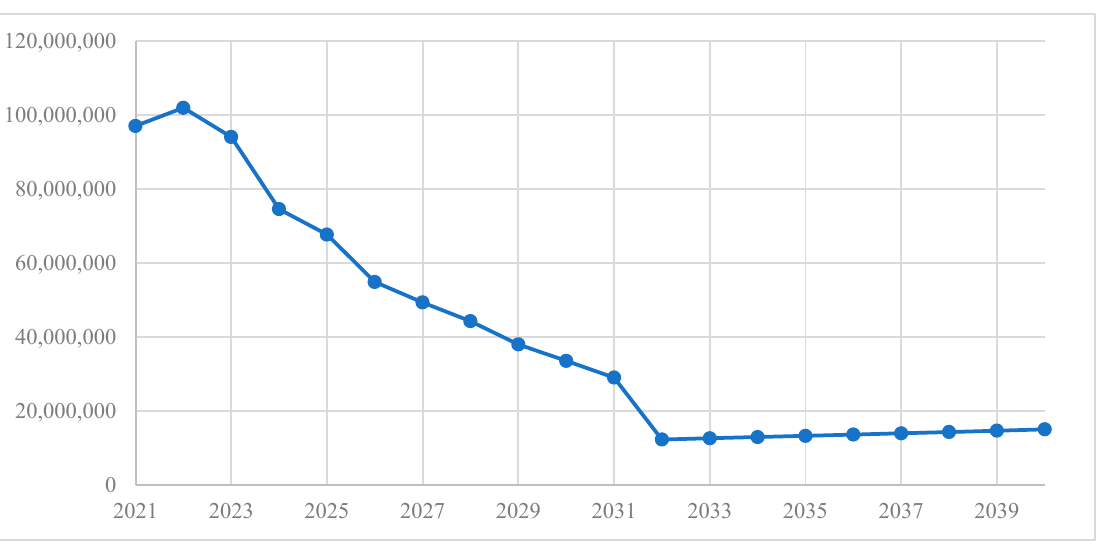
Figure 3. CO 2 emissions between 2021–2040 (tons).